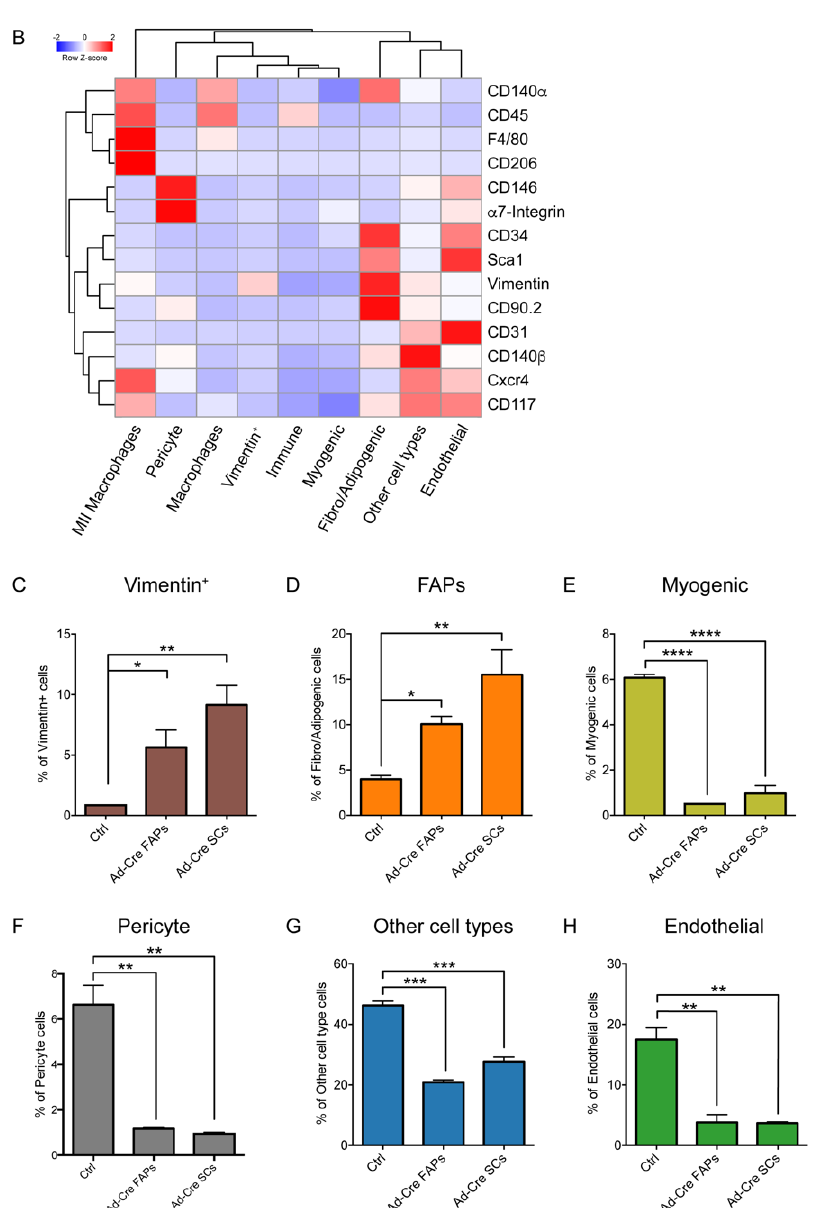
Figure 4. Mass-cytometry analysis of allograft tumors generated in NOD/SCID immunocompro- mised mice upon Ad-Cre FAP and Ad-Cre SC inoculation. ( A ) Variation in skeletal muscle-cell popu- lation abundance 3.5 weeks after the inoculation of Ad-Cre FAPs and Ad-Cre SCs into NOD/SCID mice. The dynamic changes are illustrated by representative density plots generated with the Flow- SOM algorithm. ( B ) FlowSOM heatmap of column-normalized (z-score) marker expression for each of the identified clusters. Colors varied according to the expression level of the considered marker in a blue-to-red scale, indicating low to high expression, respectively. ( C – H ) The bar plots quantitate the variation in population abundance evaluated 3.5 weeks after cell inoculation. Cell percentages were assessed on the total number of cells in each sample ( n = 2). The statistical significance was estimated by one-way ANOVA. All data are represented as mean ± SEM, and the statistical significance was defined as * p < 0.05; ** p < 0.001; *** p < 0.001; **** p < 0.0001.